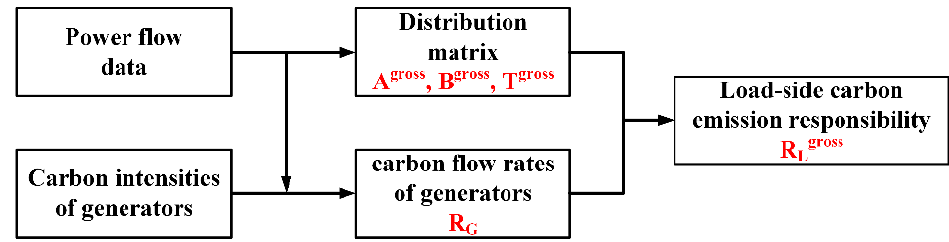
Figure 2. Schematic of the CEF calculation method.